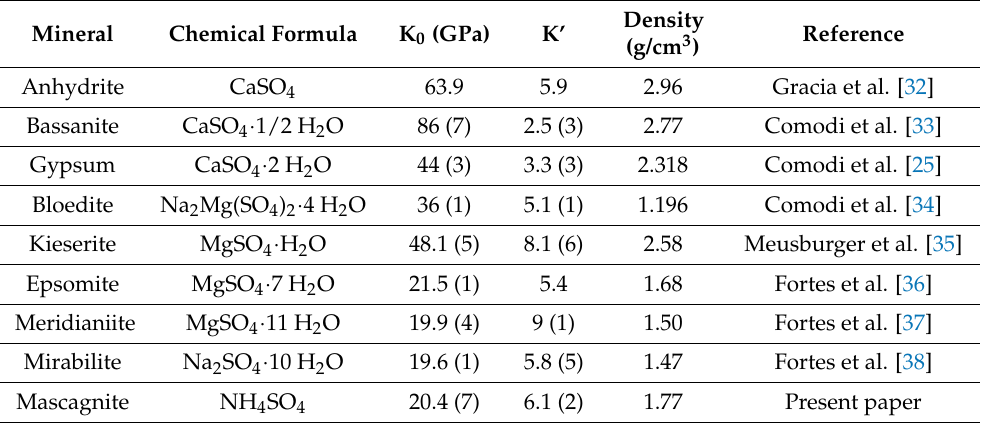
Table 5. K 0 and K’ measured in sulfates of different alkaline (Na) and earth alkaline (Ca, Mg) metals, and with different numbers of water